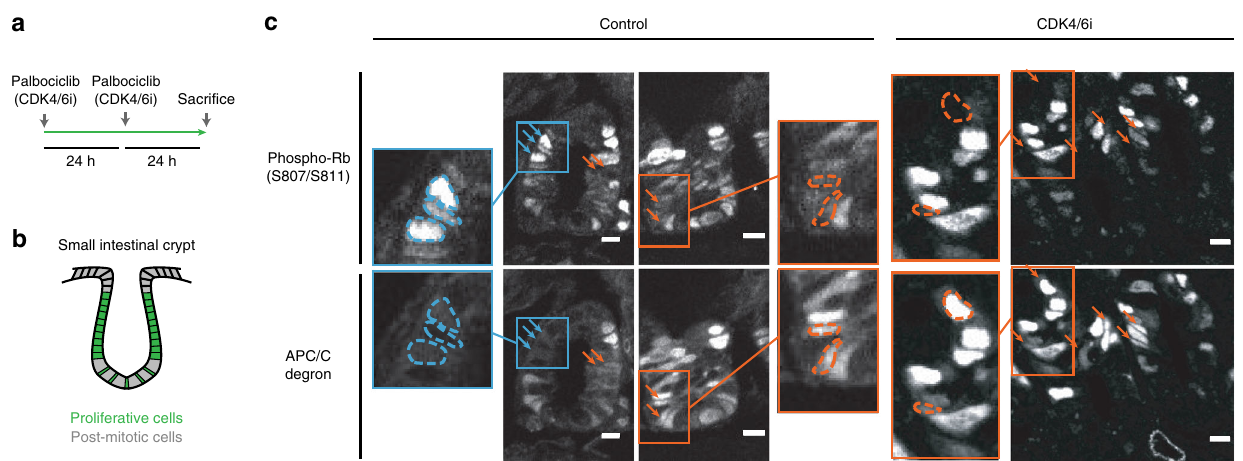
Fig. 5 A fraction of small intestinal crypt cells have the unphosphorylated Rb and inactive APC/C CDH1 characteristic of cells entering the cell cycle without CDK4/6 activity. a Experiment setup for drugging mice. b Illustration of proliferative and post-mitotic cells in the small intestinal crypt. c Mice small intestinal crypts that were treated with vehicle or CDK4/6 inhibitor. The cells express the APC/C activity reporter and were stained for phospho-Rb (S807/S811). Blue arrows and outlines denote example cells with high phospho-Rb and low APC/C degron signal. Orange arrows and outlines denote cells with high APC/C degron and low phospho-Rb signal. Crypts are oriented in U-shapes. Scale bar = 10 µ m. Representative images from n = 5 mice for control and n = 6 mice for CDK4/6